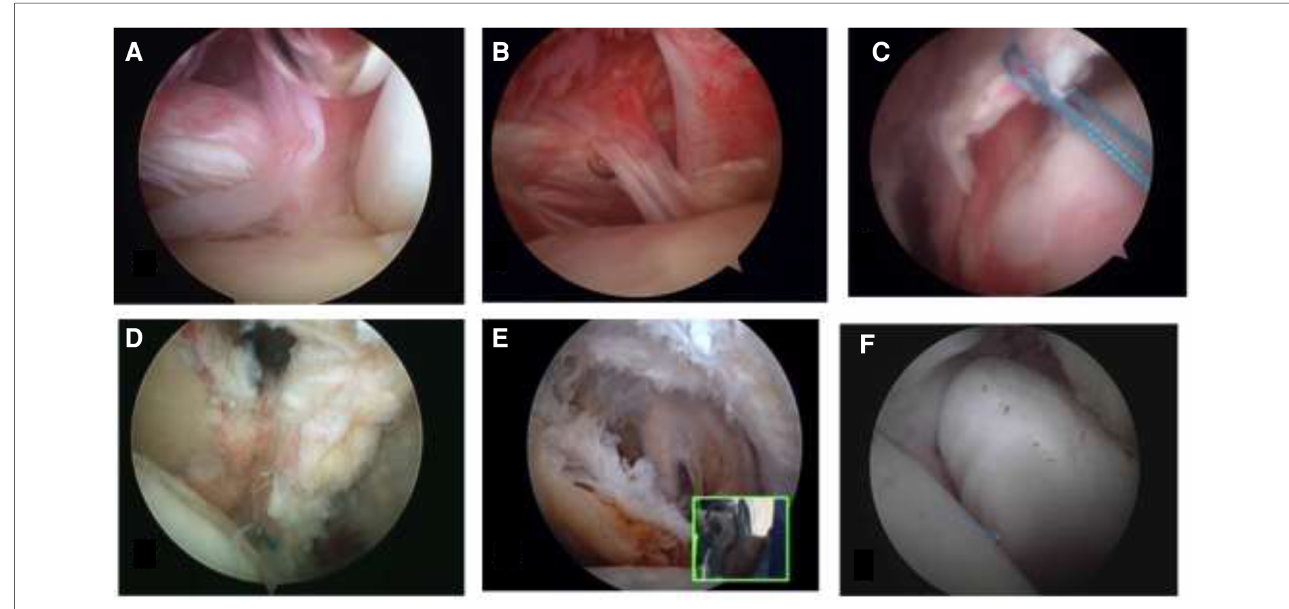
FIGURE 5 Arthroscopic view of the Lafosse classi fi cation of subscapularis tendon tears ( A – D ) (4), airbag sign, an arthroscopic fi nding of interstitial tears of the subscapularis tendon